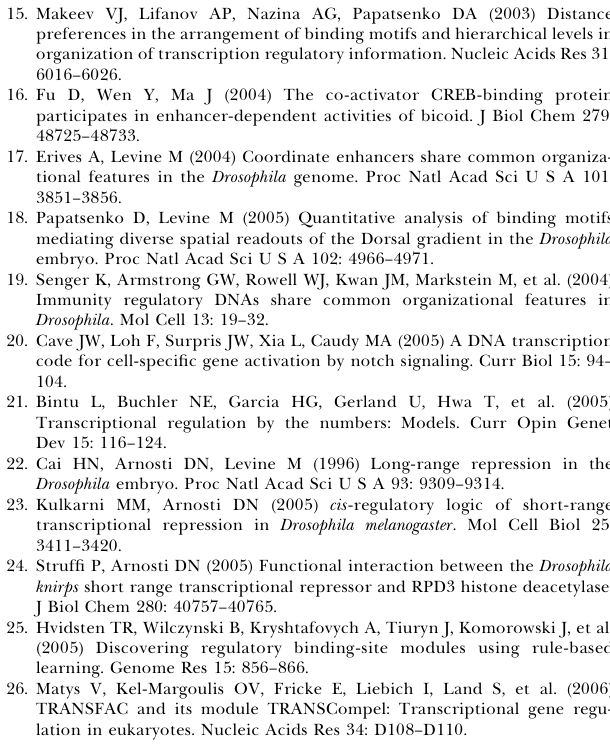
Figure S1. Dependence of Enhancer Response on Models, Structural Elements, and Mechanisms Panels on the left, (A,C,E,G,I), show transcriptional responses; panels on the right (B,D,F,H,J) show ratios between the response functions. (A) Disagreement between two models for a cooperative array (Equations S8 and S9). (B) Ratio between the two models for different numbers of sites, M . (C) Disagreement between models for cooperating competitive arrays (blue, Equation S10; green, Equation S11; red, Equation S12). (D) Ratio between model Equation S11 and model Equation S12 for different values of M . (E) Responses of one-, two-, and three-module configurations for a six-site cooperating competitive array.